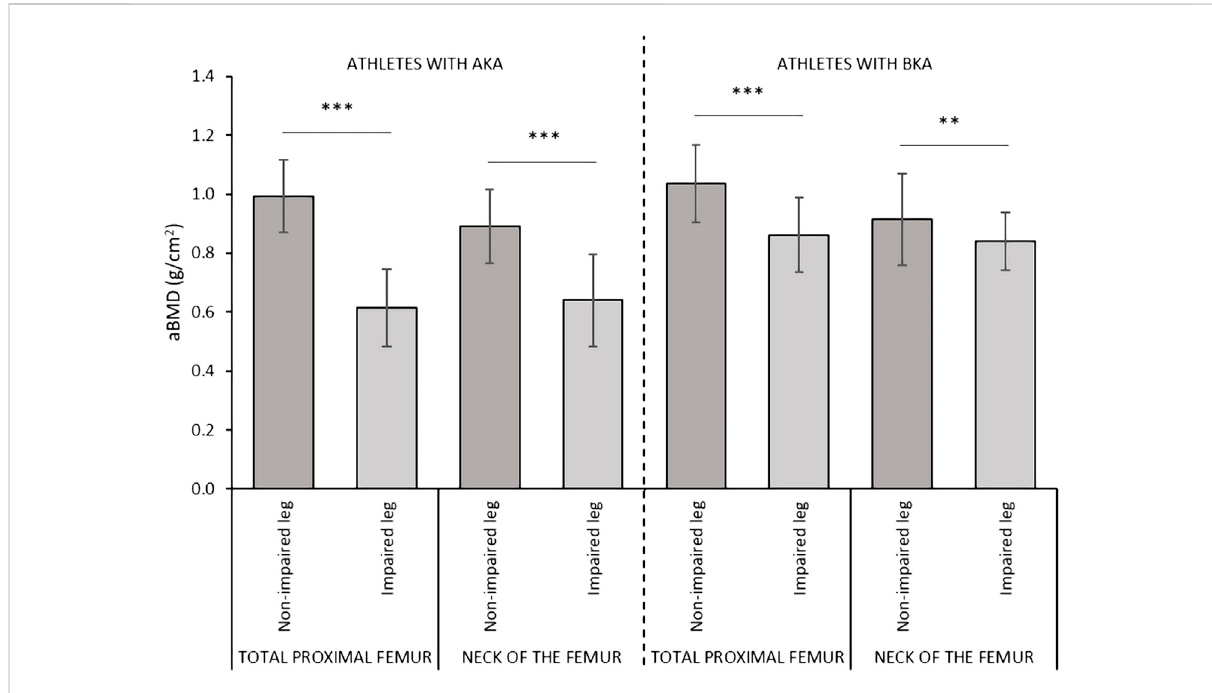
FIGURE 2 Comparisons of the aBMD values between the impaired and non-impaired leg according to the level of amputation. Data are presented as mean±standarddeviation. Legend.aBMD, arealbonemineraldensity; AKA,above-kneeamputation;BKA,below-kneeamputation.*p ≤ 0.05;**p ≤ 0.01; ***p ≤